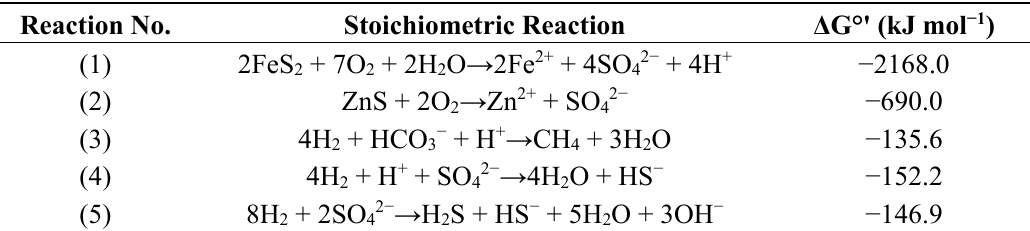
Table 1. Standard Gibb’s free energies for selected reaction stoichiometries. Reaction